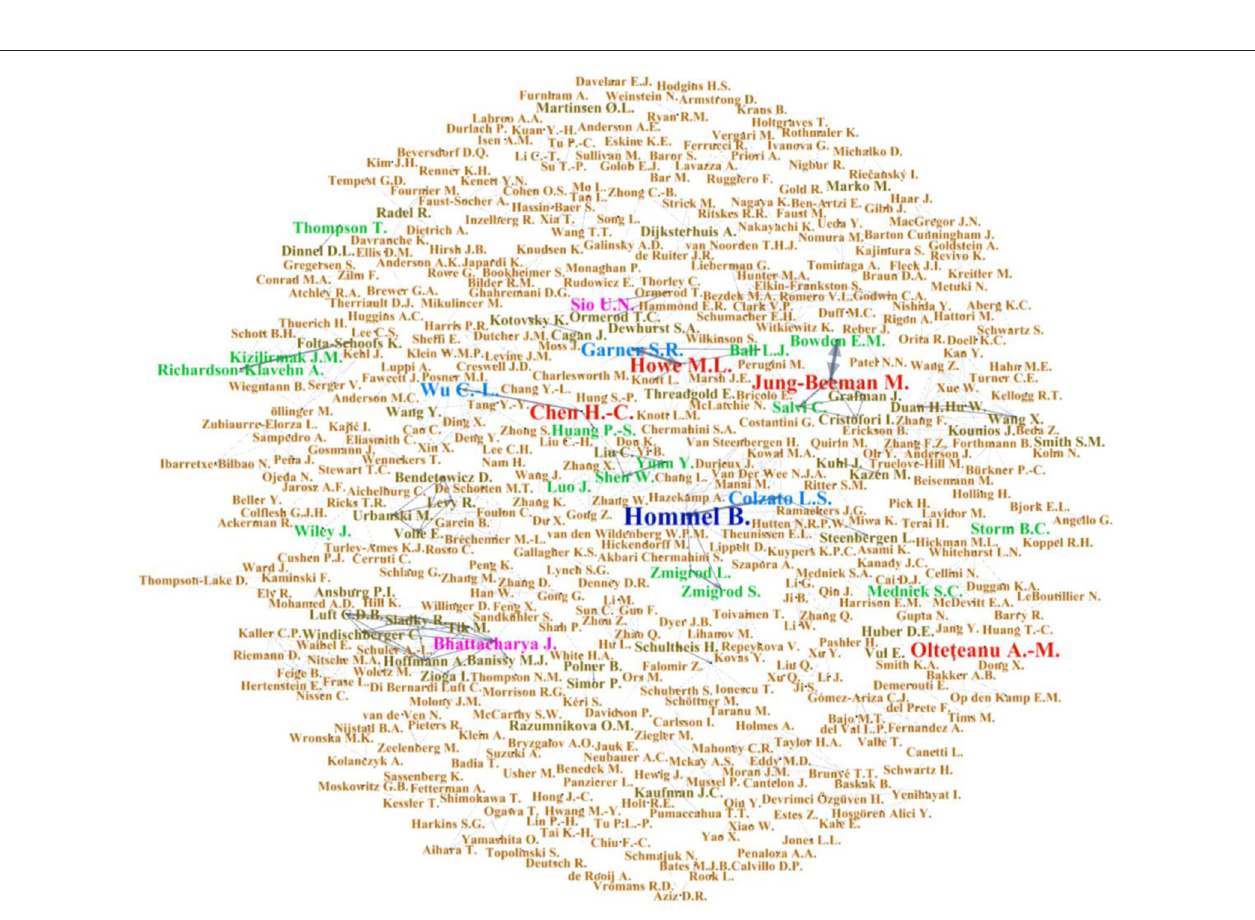
Frontiers in Psychology |